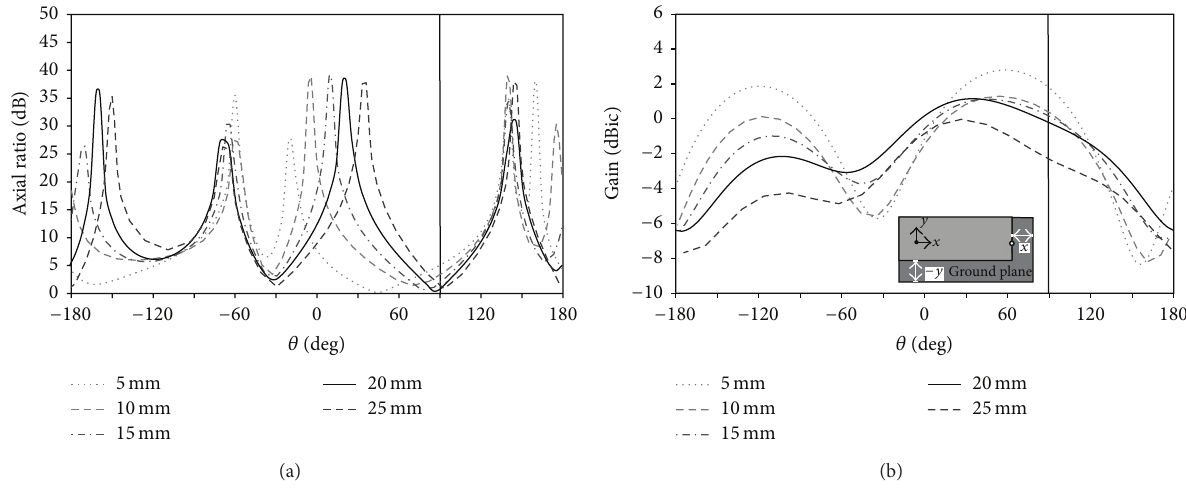
Figure 13: Simulated results of (a) AR pattern and (b) antenna gain in y-z plane at 925 MHz as a function of the extension in + x - and − y - direction g ( 𝜙 = 90 ∘